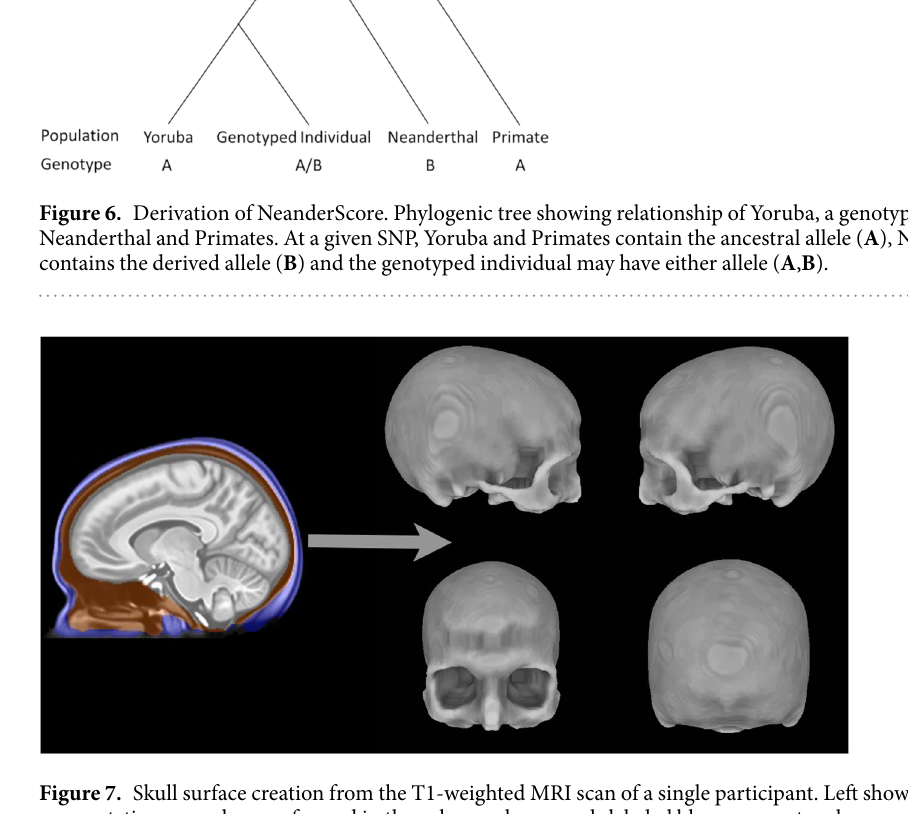
Figure 7. Skull surface creation from the T1-weighted MRI scan of a single participant. Left shows the segmentation procedure performed in the volume where v oxels labeled blue represent scalp, orange voxels represent skull, and gray voxels represent the intracranial area. Right shows the 3D skull surface derived from voxels labeled as skull (orange) in the